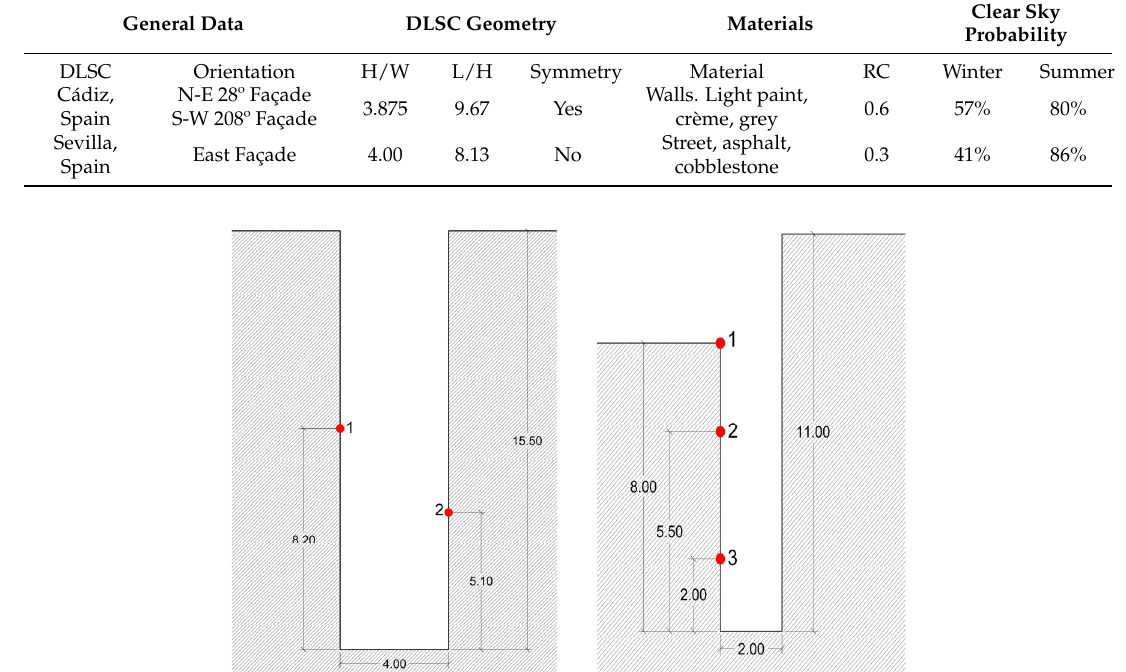
( b ) Figure 8. 24 h comparison between cell measurements and simulations, summer in Cadiz. ( a ) N-E 28º Façade. ( b ) S-W 208º Façade.